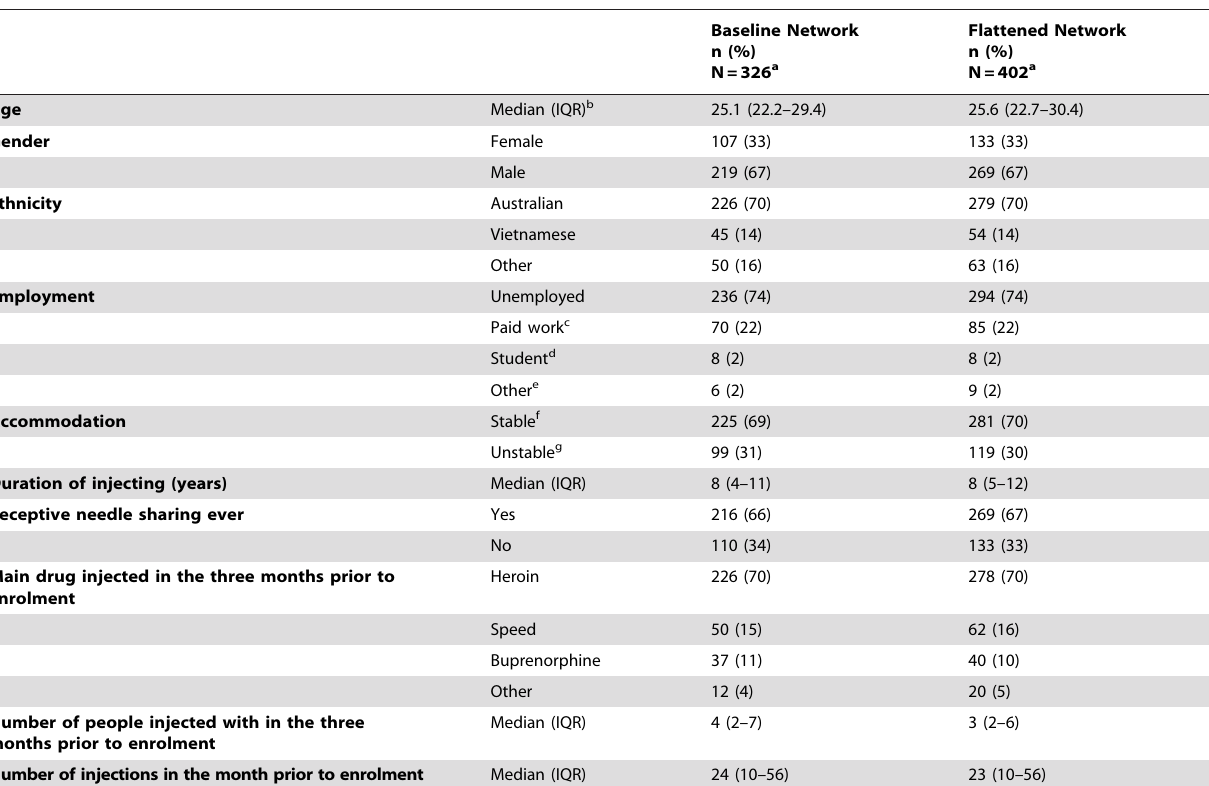
Table notes: a Totals may not sum to n due to missing data. b IQR: interquartile range. c Including full-time, part-time and casual employment. d Including full-time and part-time students. e Pensioners, home-duties. f Including own home, renting, and living with parents. g Including homeless, squat and boarding. doi:10.1371/journal.pone.0047335.t001 PLOS ONE |